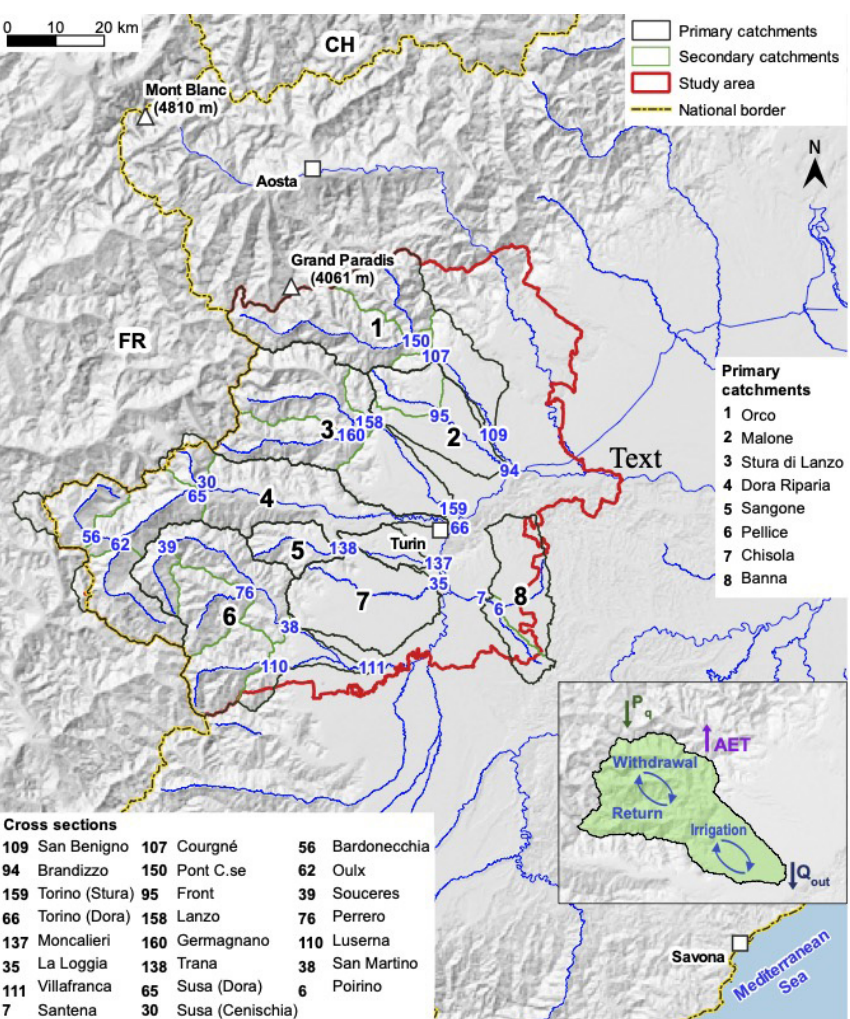
Figure 1. The study area including river catchments and sub-catchments. Illustration of the water balance terms at the catchment scale is shown in the inset. Topographic shading is based on DEM data from the “Progetto Risknat – Base topografica transfrontaliera, ARPA Piemonte” (http://webgis.arpa.piemonte.it/ags101free/rest/services/topografia_dati_di_base/Sfumo_Europa_WM/MapServer, last ac- cess: 14 August